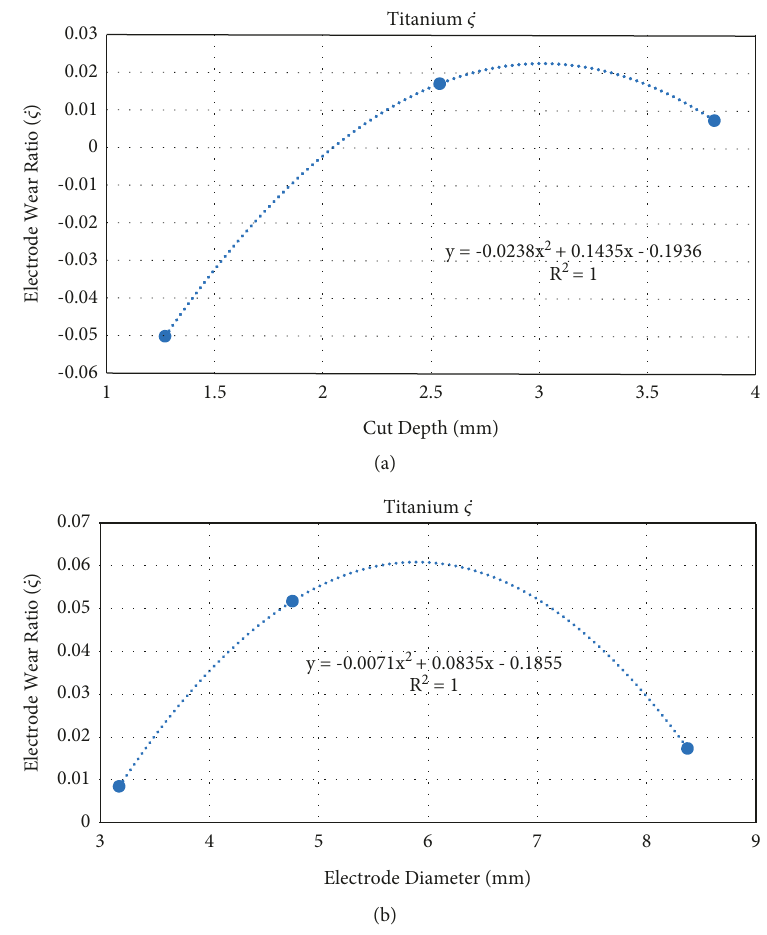
Figure 11: Mean _ ς due to cut depth (a) and electrode size (b) in